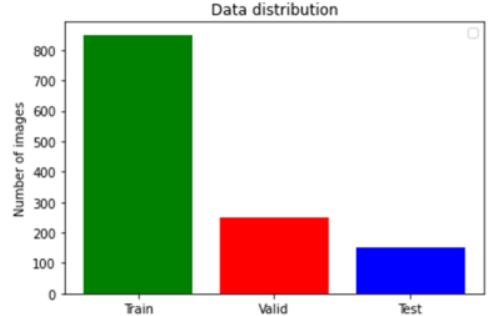
Figure 3. Dataset distribution.